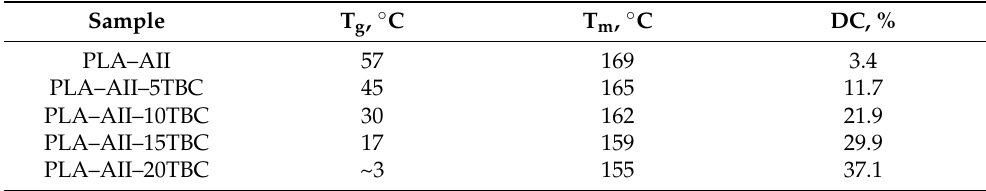
Table 4. Comparative DSC * of PLA/AII composites with/without plasticizer (TBC) determined on previously cooled samples by 40 ◦